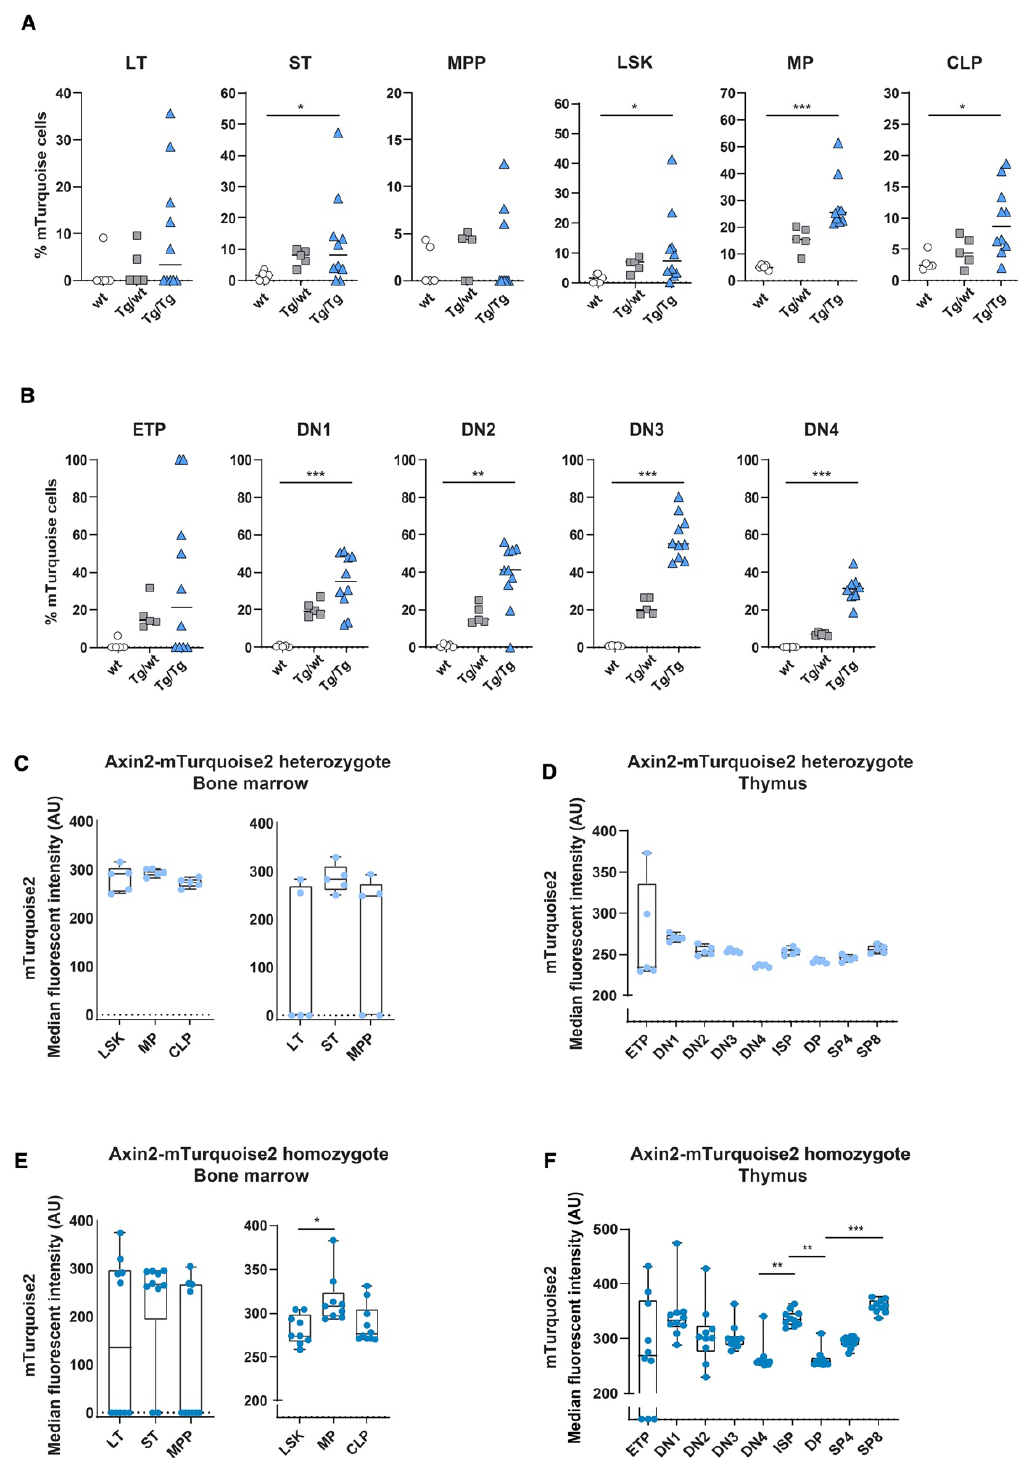
Figure 4. In vivo measurement of canonical Wnt signaling activity in hematopoietic stem cells and T cell development after competitive transplantation. Activation of the canonical Wnt signaling pathway was measured in the Axin2-mTurquoise2 test population (Ly5.2) fraction of the transplanted recipient mice by FACS. Quantification of the frequency of mTurquoise2 ( A , B ) for each subset in the bone marrow ( A ) and in the thymus ( B ). The test population (Ly5.2) fraction not carrying the reporter transgene (Axin2-mTurquoise2 wild type) was used to define the mTurquoise2 population. Data represent results for five wild-type control mice (wt), five heterozygous Axin2-mTurquoise2 mice (Tg/wt) and ten homozygous Axin2-mTurquoise2 mice (Tg/Tg) from two inde- pendent experiments. ( C , D ) Quantification of the median fluorescence intensity (MFI) of the mTur- quoise2 populations of heterozygous Axin2-mTurquoise2 (Tg/wt) mice for each subset in the bone